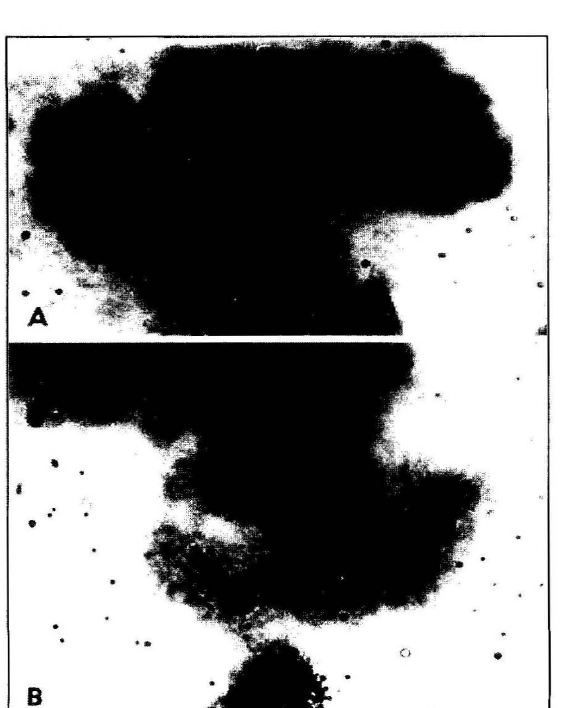
Figure 3. A: Macrophageal l'\1- 1 colon\'; B: macrophageal/ granulocyte (MG- ) (0)011\: in murine bone marrow